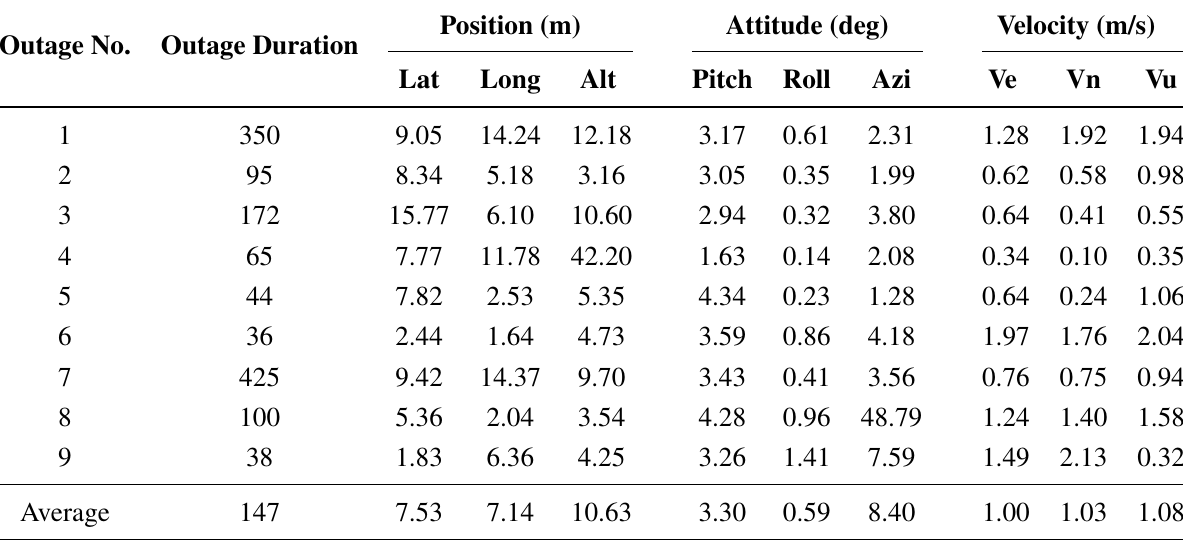
Table 3. RMS errors during full outages for the Toronto downtown trajectory.